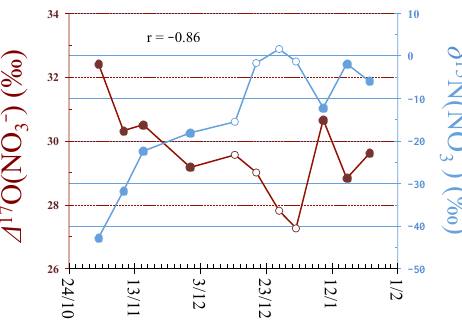
Figure 1. Atmospheric nitrate concentrations observed between November 2011 and January 2012. The samples collected during the intensive measurement period (December 2011–January 2012) are indicated with open circles.